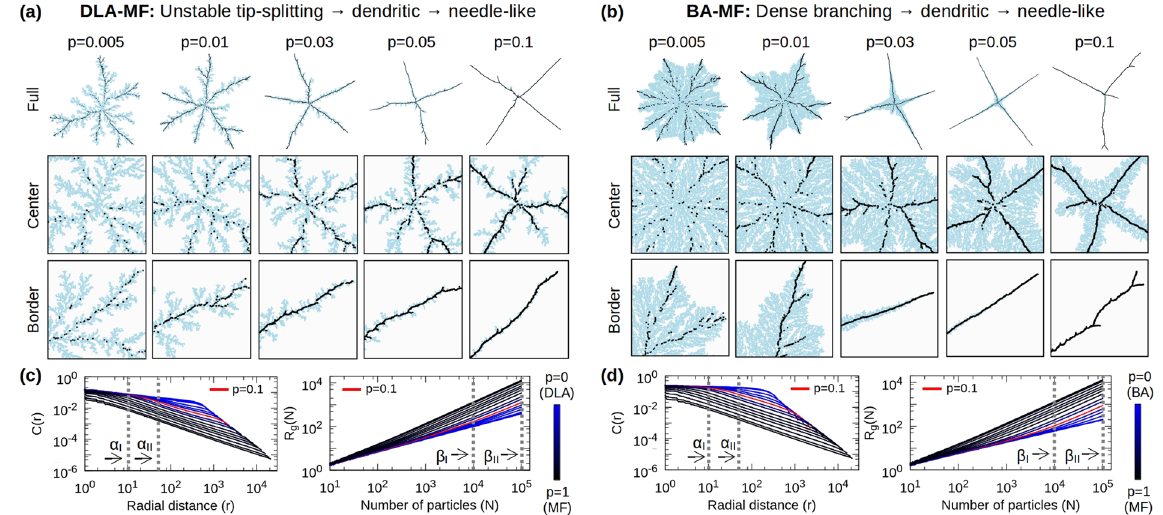
Figure 2. DLA/BA-MF Transitions. Clusters of 1.5 × 10 5 particles grown with the indicated values of p are shown at different magnifications for the ( a ) DLA-MF and ( b ) BA-MF transitions. Particles aggregated under DLA/BA are coloured in light-blue while those through MF in black. These transitions exhibit fast morphological transformations as p increases, from unstable tip-splitting (DLA) or dense branching (BA), through (inhomogeneous) dendritic, to needle-like growth (MF). ( c , d ) C ( r ) and R g ( N ) display deviations from a well-defined linear behaviour for different values of p , revealing the inhomogeneity or crossover effects in these clusters. This is better appreciated at low scales, where the stochasticity of DLA or BA dominates the local growth, whereas MF tends to dominate the global morphology as p → 1. In both cases, the dynamical growth- regime changes at ≈ .